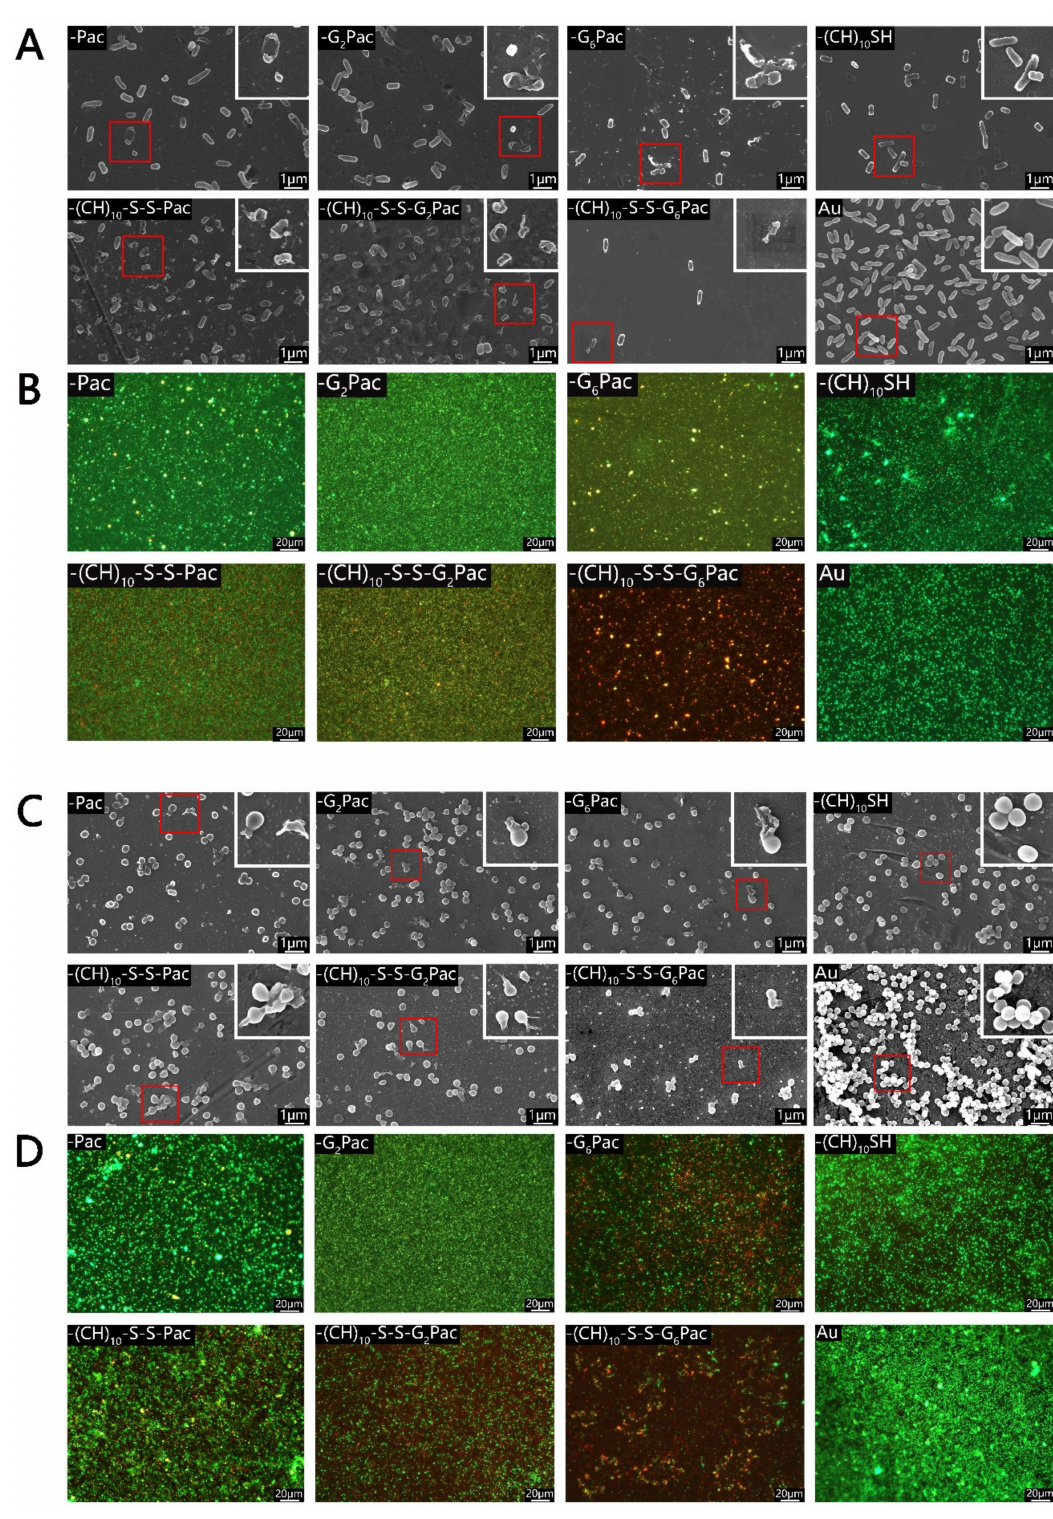
Figure 5. The typical SEM images and live/dead fluorescence images of E. coli ( A , B ) and S. aureus ( C , D ) on different SAM substrates after 24 h of